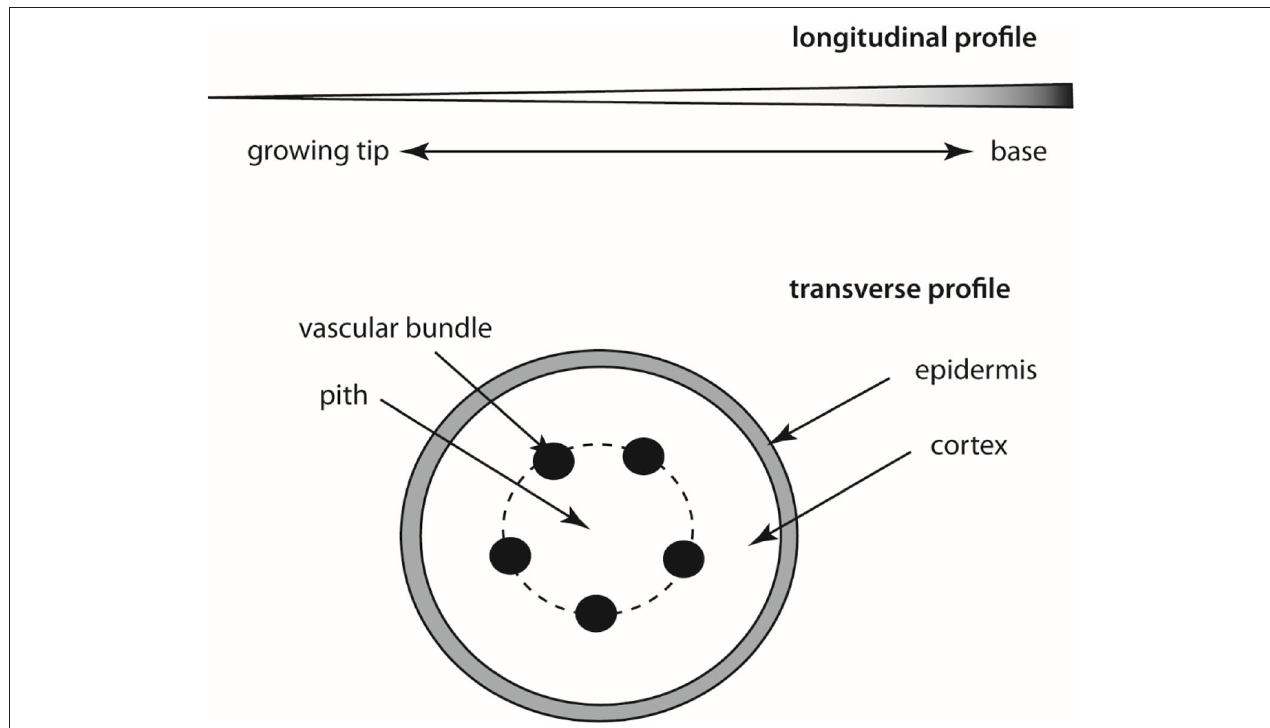
FIGURE 3 | Schematic of longitudinal tapered profile (top) and a transverse section (bottom) through a typical tendril-like stem. The shading in the longitudinal section denotes increasing stiffening toward the base of the stem as a consequence of an increase in cross sectional area and lignification of